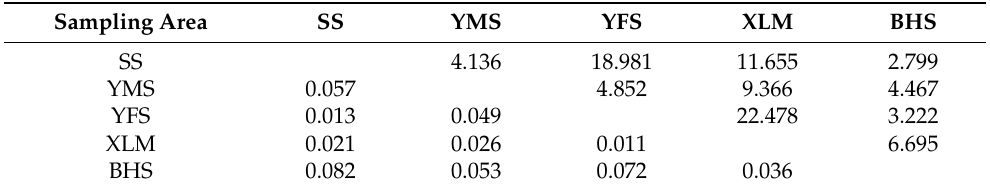
Table 4. Fst and Nm based on analyses of the diversity of microsatellite loci in leopard cat subpopula- tions in the five sampling